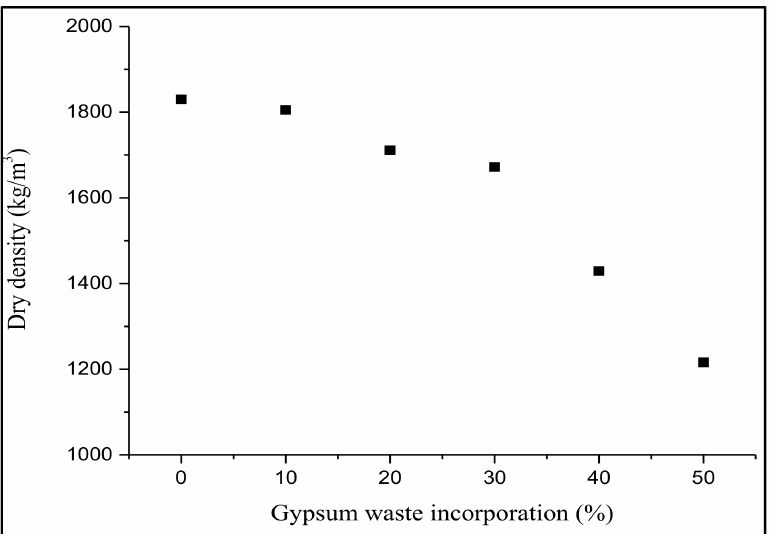
Figure 3. Effect of gypsum waste utilization on the dry density of fired clay